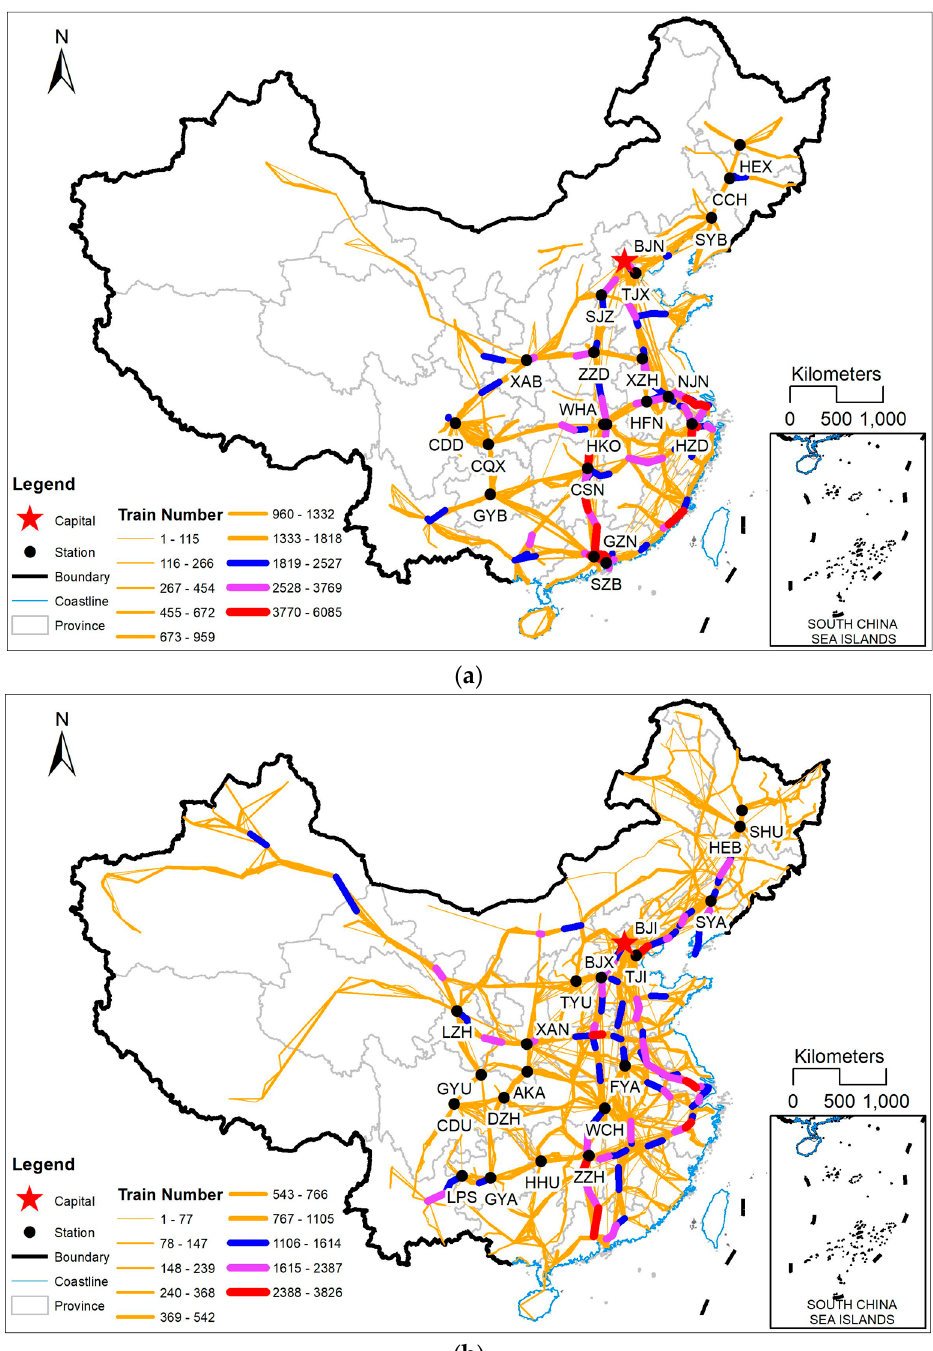
Figure 7. Distribution of stations with largest betweenness in the geographic railway network. ( a ) Station with the largest betweenness in high-speed railway network. ( b ) Station with the largest betweenness in normal-speed railway.